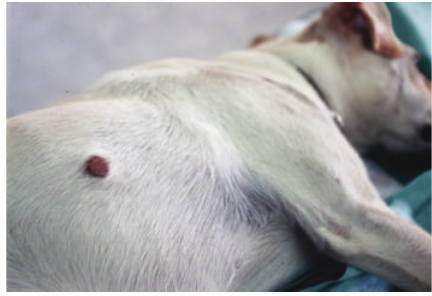
Figure 5: Nodule on the flank of a dog from Italy (Alessandria province) containing an adult female Dirofilaria repens parasite.